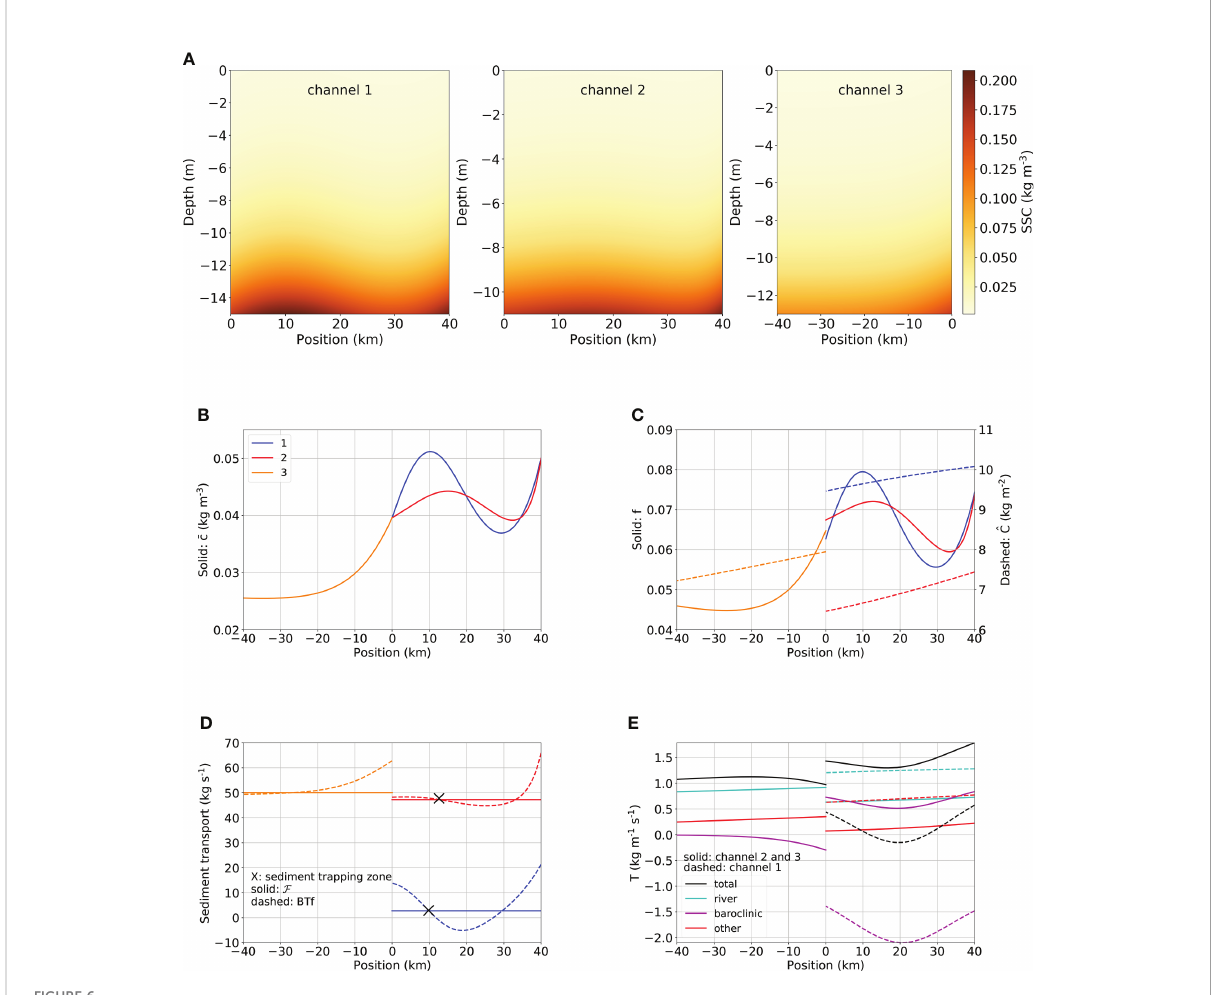
FIGURE 6 Results for the reference case. (A) Subtidal suspended sediment concentration (SSC) in the three channels. (B) The subtidal depth-averaged SSC c . (C) Availability f (solid lines) and carrying capacity ^ C (dashed lines). (D) The net sediment transport F (solid lines) and the advective transport BTf (dashed lines). (E) Difference contributions to T , the transport capacity per unit of